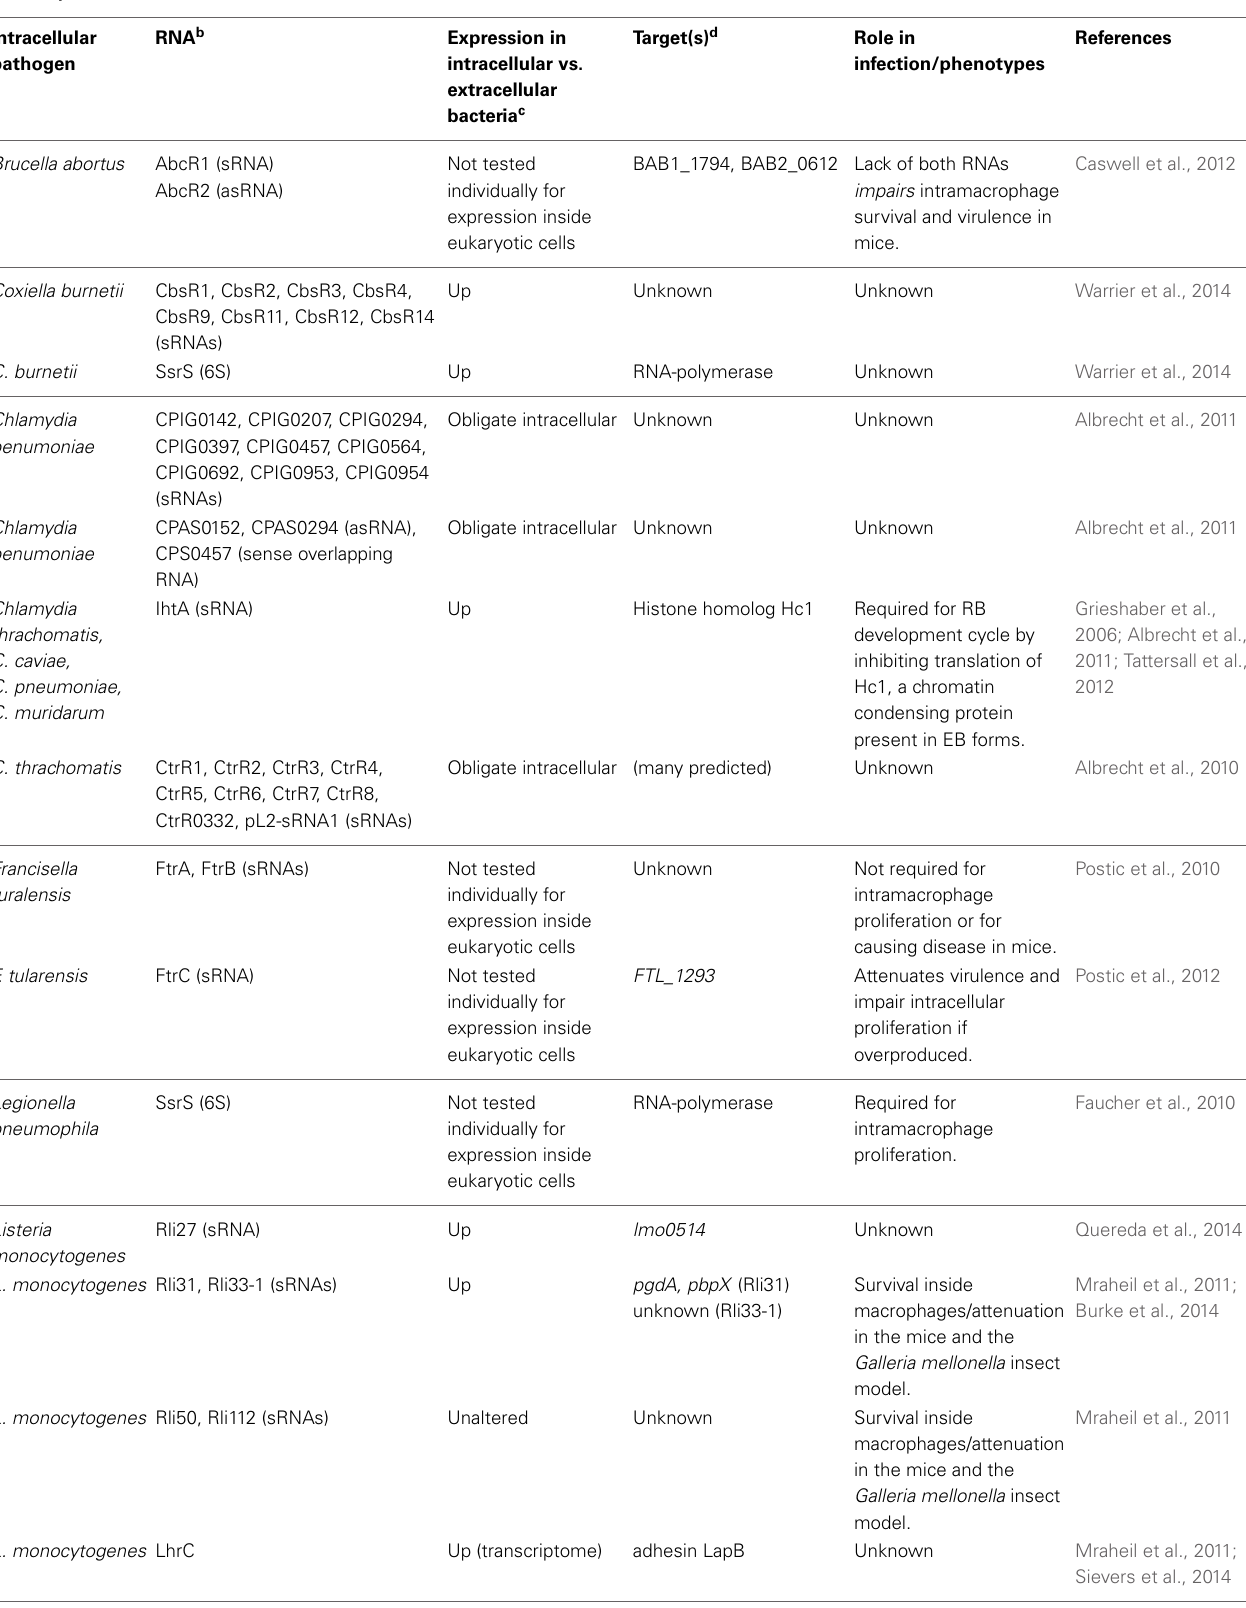
Table 1 | Non-coding RNAs of bacterial pathogens validated experimentally during the intracellular infection of eukaryotic cells a